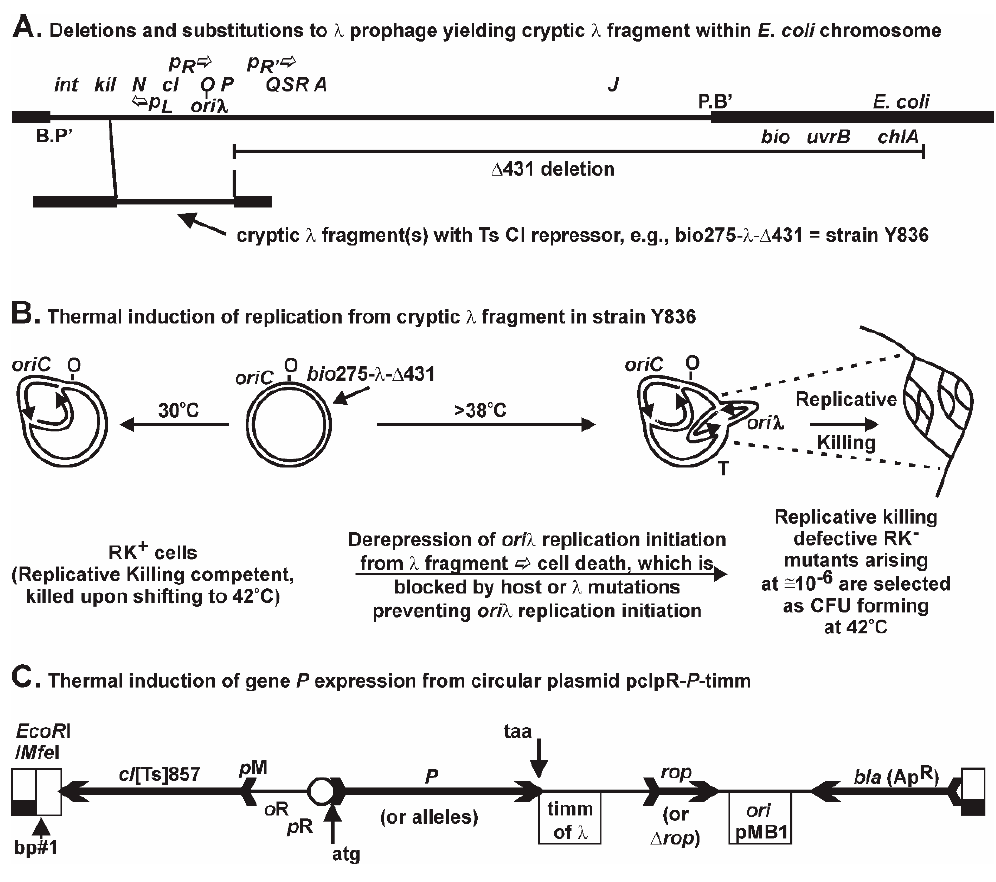
Figure 1. Modes for expression of P : ( A ) cryptic prophage map (for more λ gene detail refer to Figure 1B in reference [35] or Figure 1 in reference [36]); ( B ) λ gene expression is induced by shifting cells from 30 °C to 42 °C, which inactivates the encoded Ts (temperature sensitive) cI [Ts]857 repressor, permitting rightward transcription from promoter p R; and ( C ) an exact copy of P (or alleles of P ) was cloned into the synthetic expression plasmid pcIpR ‐ timm [35] (shown by arrows at ATG and TAA). P expression from pcIpR ‐ P ‐ timm is controlled by the λ CI[Ts] repressor. The circle to the right of pR and left of ATG represents the ribosomal binding site for the deleted intervening gene cro . The transcription of P from the plasmid terminates at the transcriptional terminator timm , which in the wild type λ sequence prevents both the low maintenance and high level establishment modes of cI ‐ rexA ‐ rexB transcription from transcribing leftward from p M or p E into o L ‐ p L [37].